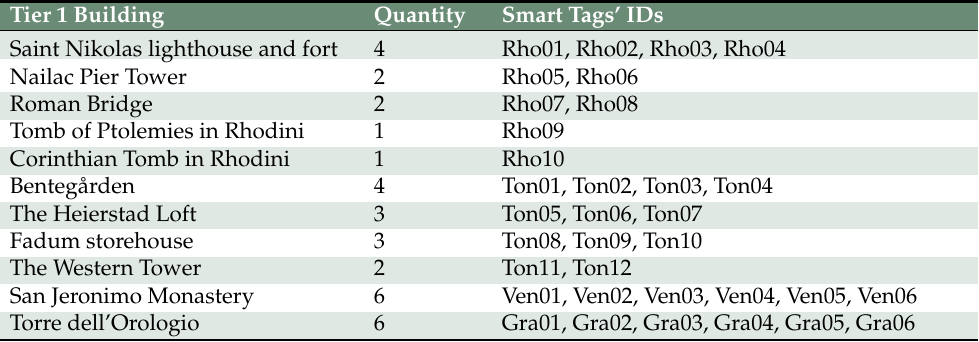
Table 3. The Smart Tags’ distribution in the Tier 1 buildings of CH